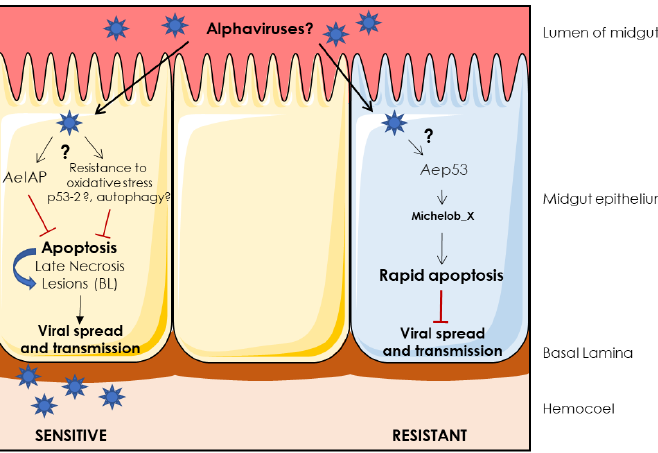
Figure 3. Possible interplay between cell death and alphavirus infection in Aedes mosquitoes: extrapolation from other arboviruses studies. BL: basal lamina, Ae IAP: Aedes inhibitor of apoptosis protein. See Box 1 for RCD pathway description in insect.